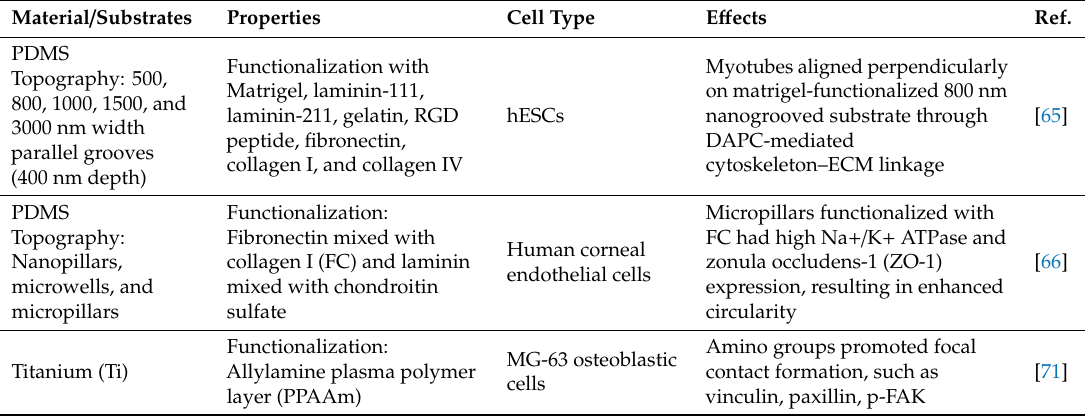
Table 4. Studies reporting the e ff ects of surface functionalization of substrates on